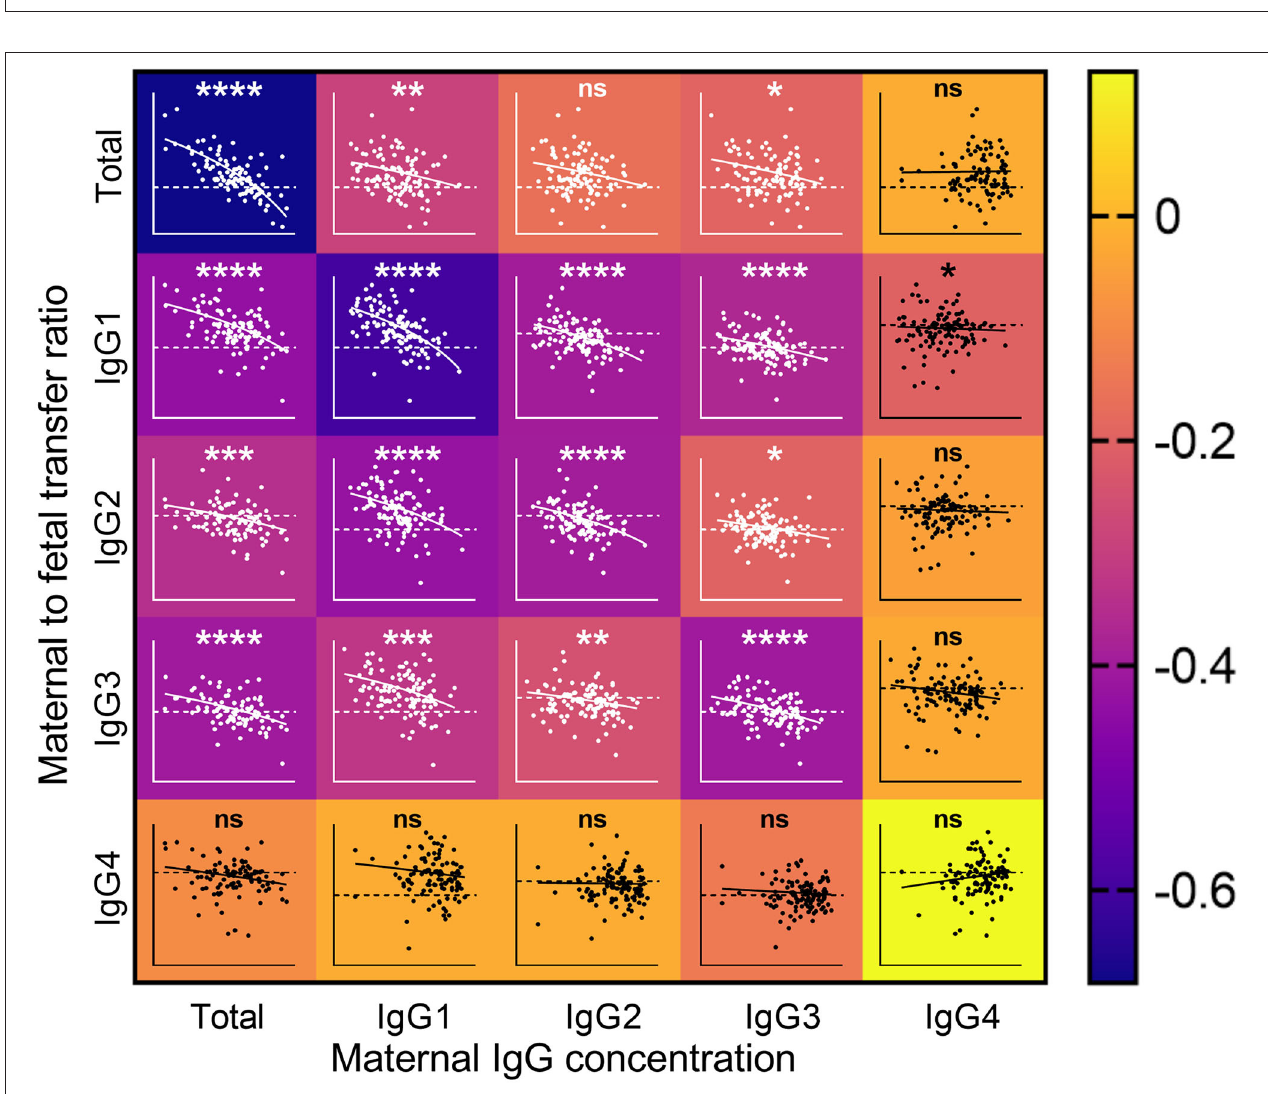
FIGURE 2 | multiple comparisons test. (D) Maternal to fetal transfer ratios of IgG1–4 represented on log(2) scale broken down by gestational age at delivery. Values > 1 indicates higher levels in cord blood, indicated by dashed line. Analysis performed on log(2) transformed transfer ratios, using Repeated Measures One Way ANOVA and Holm Sidak’s multiple comparisons test. Hierarchy of IgG1 > IgG3 > IgG2 > IgG4 for 37–38 weeks and 40 + weeks gestation. Hierarchy of IgG1 > IgG3 > IgG4 > IgG2 for 39 weeks gestation. (E) Dot-line plots showing the relationship between IgG concentrations in maternal and cord pairs. Groups compared by paired t test on nLog-transformed data. (F) Correlations between maternal and cord IgG concentrations. Lines indicate simple linear regression. nLog values analyzed by Pearson r- test. N = 114 maternal and cord pairs. **** p < 0.0001, *** p < 0.001, ** p < 0.01, * p < 0.05.